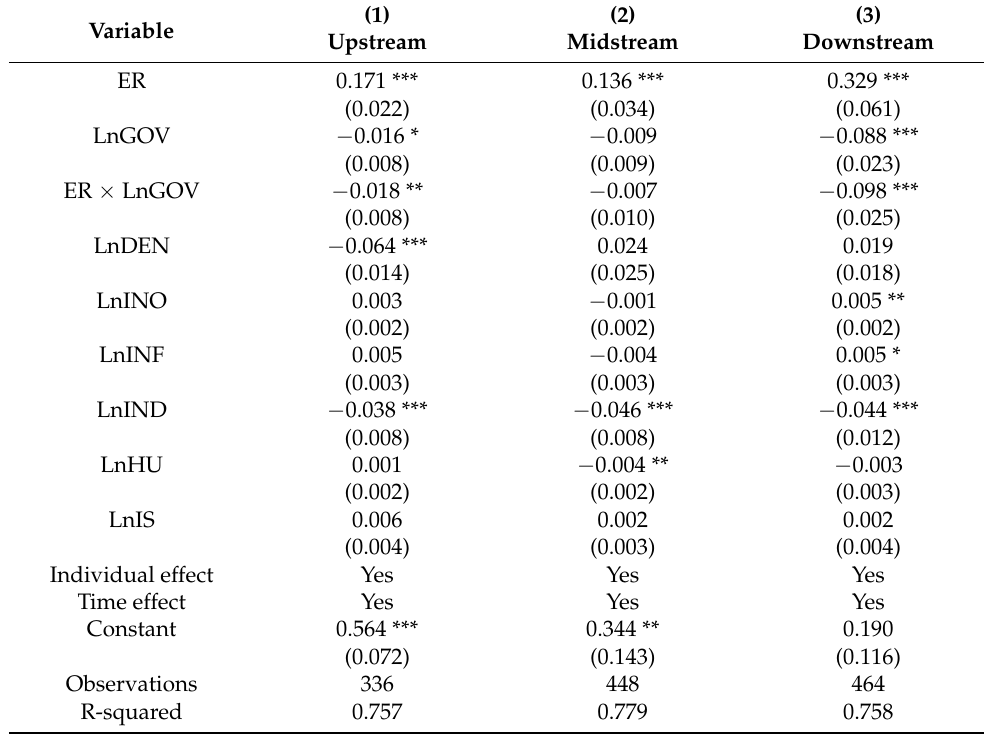
Table 6. Heterogeneity analysis based on different